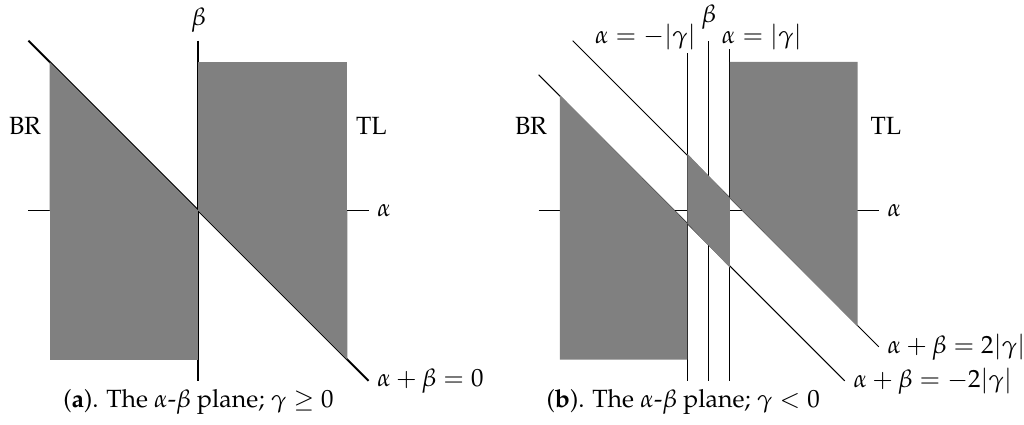
Figure 1. Conflict and agreement with α , β